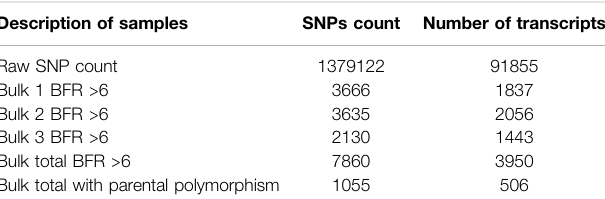
TABLE 3 | Number of transcripts containing SNPs having BFR > 6 in bulked samples. Description of